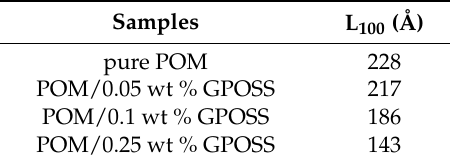
Table 2. Crystal size ( L hkl ) evaluated according to the Scherrer formula.